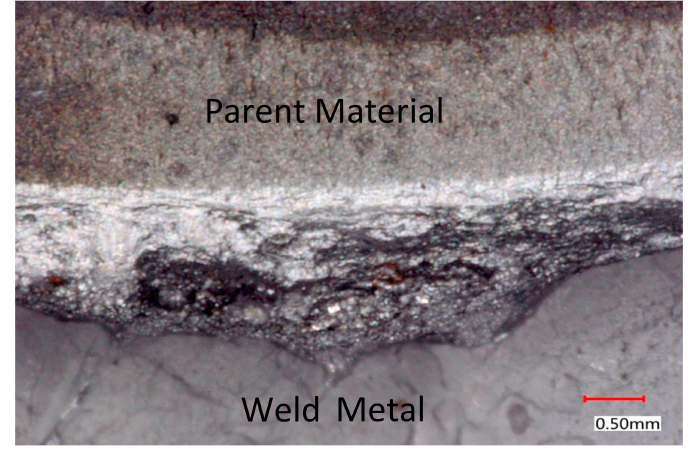
Figure 10. HAZ fracture surface